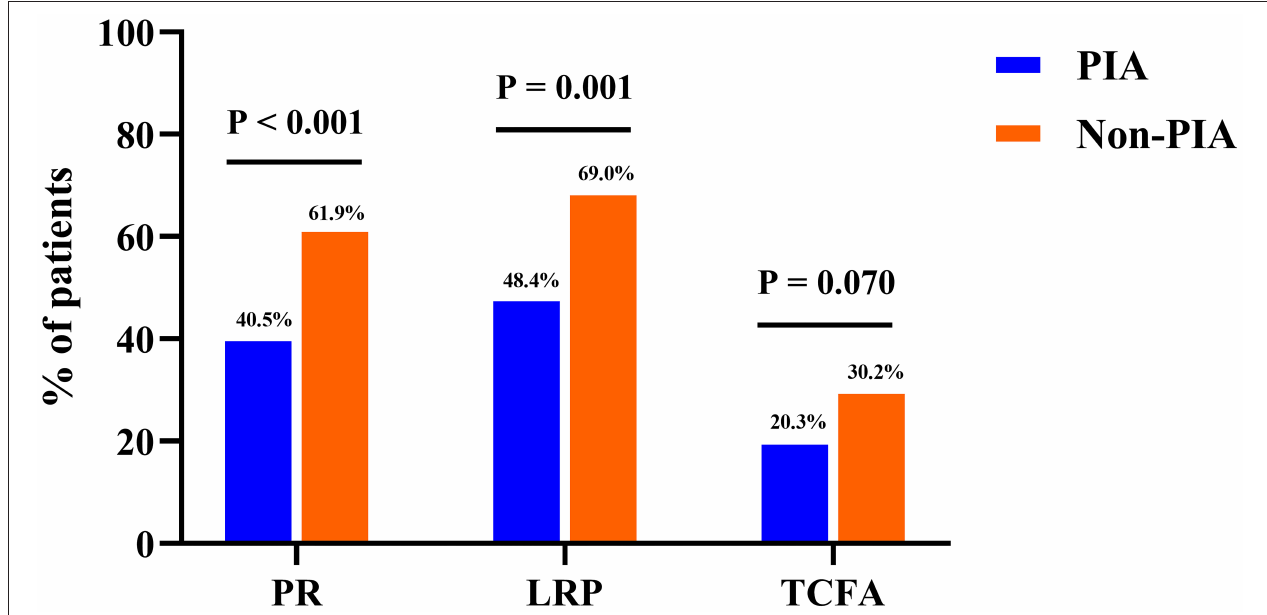
FIGURE 3 | Bar graphs of optical coherence tomography findings of coronary plaques between groups. Comparisons of the incidence of plaque rupture (PR), lipid-rich plaques (LRPs), and thin-cap fibroatheroma (TCFA) showed significant differences between patients in the PIA and non-PIA groups. PIA, preinfarction